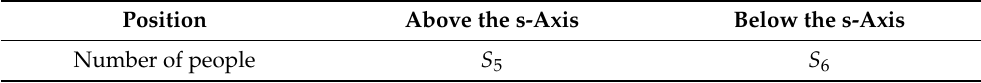
Figure 8. Determination of the statistical scope. Table 2. Pedestrian location statistics for behavioral decision making (2).